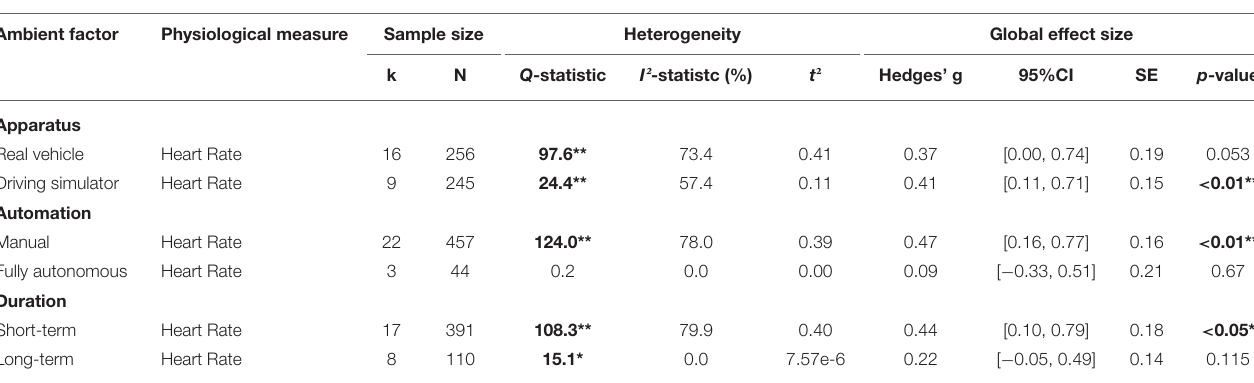
TABLE 3 | Outcomes of ambient